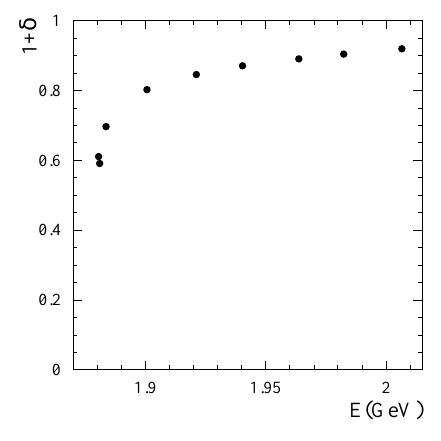
Figure 4. The radiative correction factor for the process e + e − → n ¯ n in the nine experimental en- ergy points.